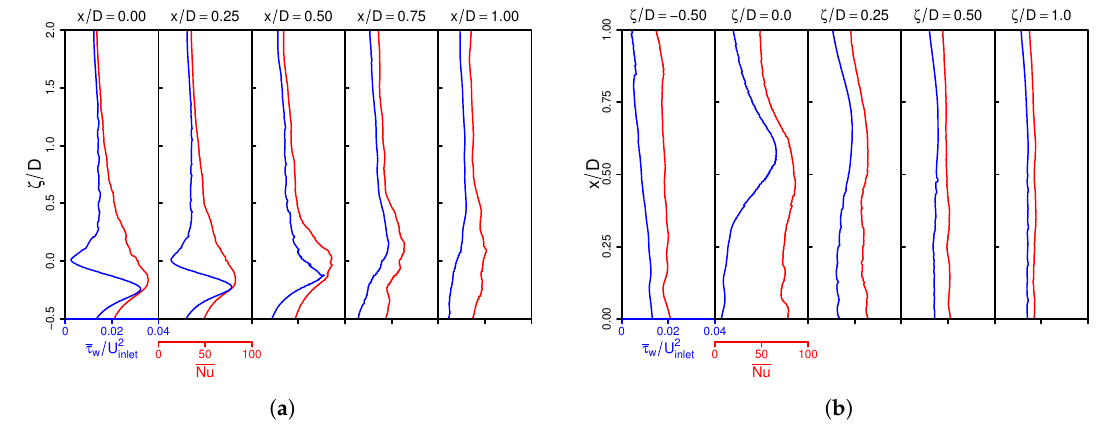
Figure 9. Profiles of the time-averaged Nusselt number ( ) and magnitude wall-shear stress ( ) in: ( a ) the span-wise direction x; and ( b ) the wall-parallel direction ζ